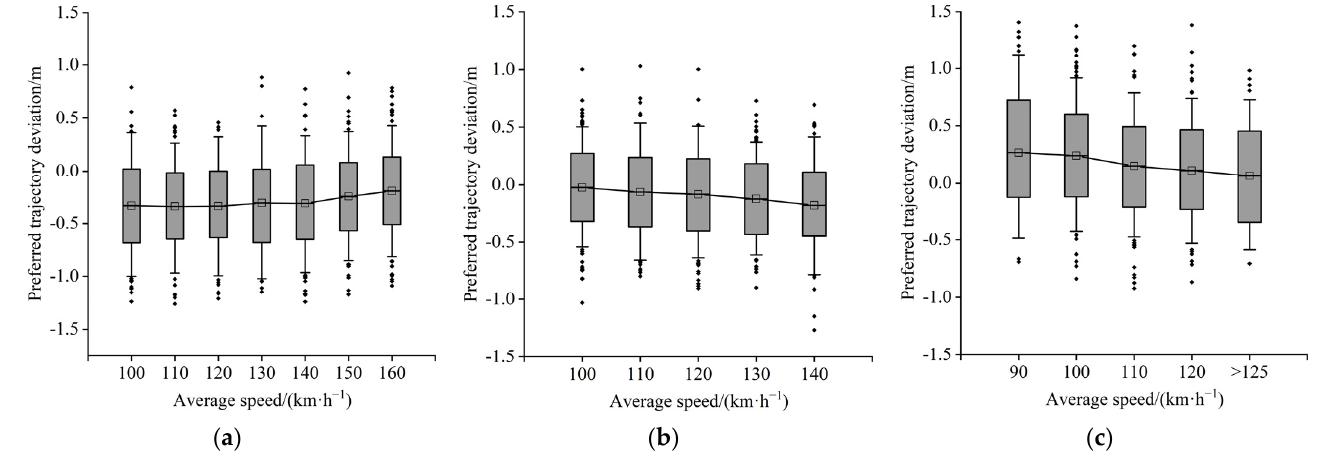
Figure 12. ( a ) Inner lane; ( b ) middle lane; ( c ) outside lane.